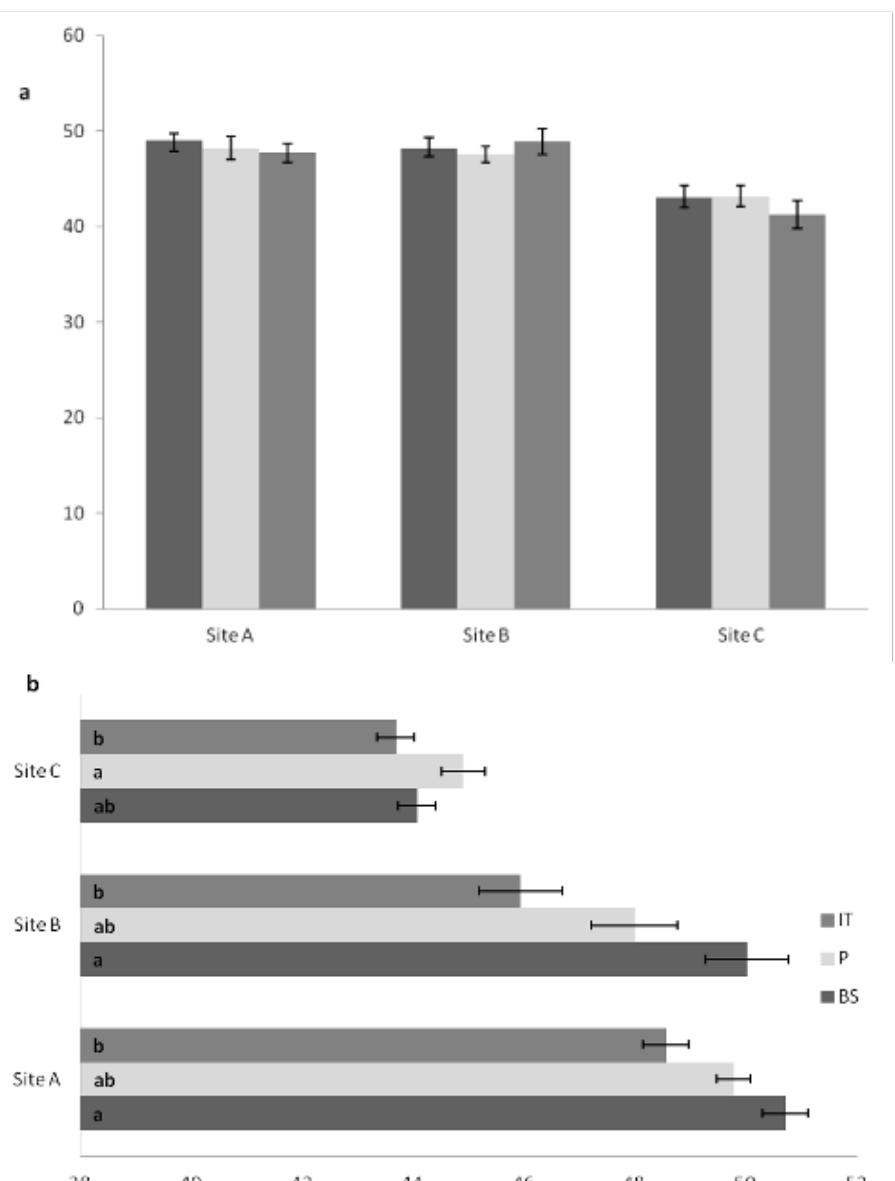
Figure 4. Average total carbon percentage in roots ( a ) and shoots ( b ) of slash pine trees of three different plantations (measured in the year 2010). Comparisons were valid only within the respective sites. Site A: 14-, Site B: 24-, Site C: 26-year-old plantations (age at the installation of the experiments). Treatments: IT = Intact; BS = Bark Streak; P = Paste. Each mean was calculated with 30 individual trees. Bars sharing a letter are not significantly different by the Tukey test ( p ≤ 0.05).